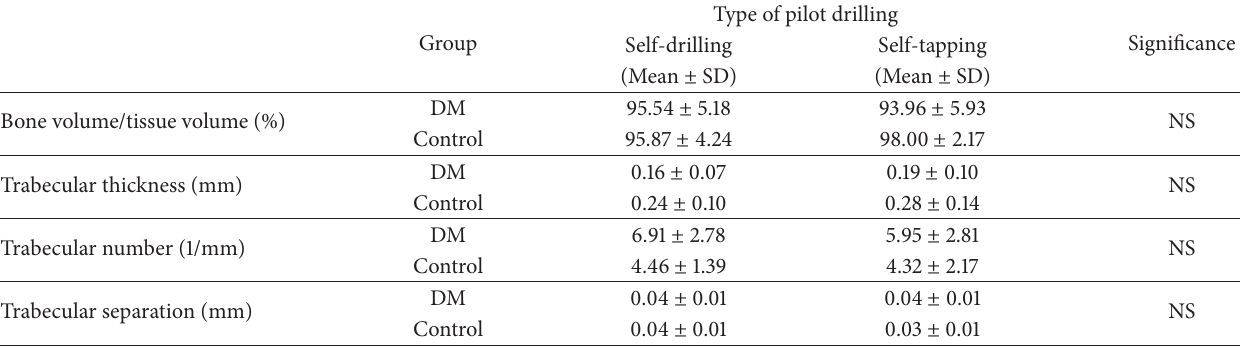
Table 3: Three-dimensional bone microstructure analysis in cortical bone area. Group